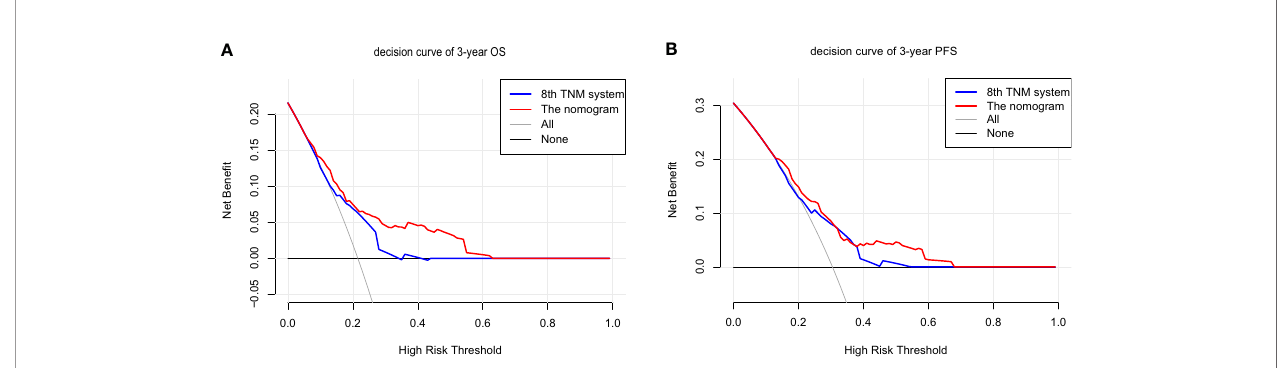
FIGURE 4 | The decision curves (DCA) of OS (A) and PFS (B) at 3 year by the nomogram and the eighth UICC/AJCC TNM staging system.